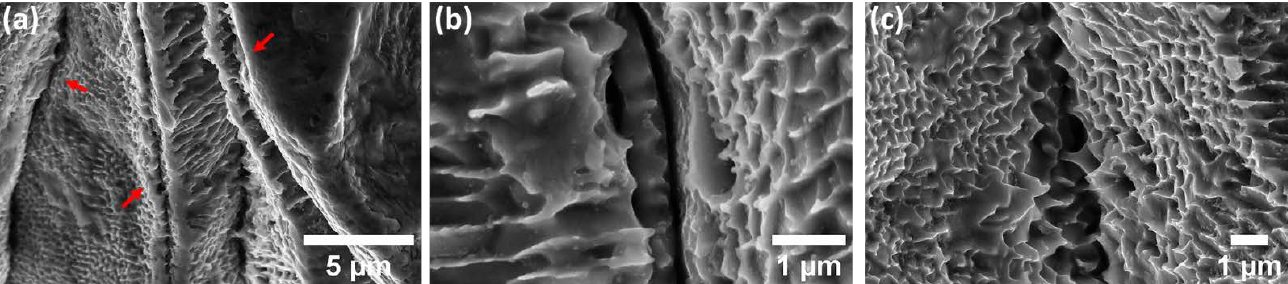
Figure 8. (a – c) High-resolution FEG-SEM images of the specimens in groups one and two highlighting the SCC morphology (shown by red arrows in ( a )).